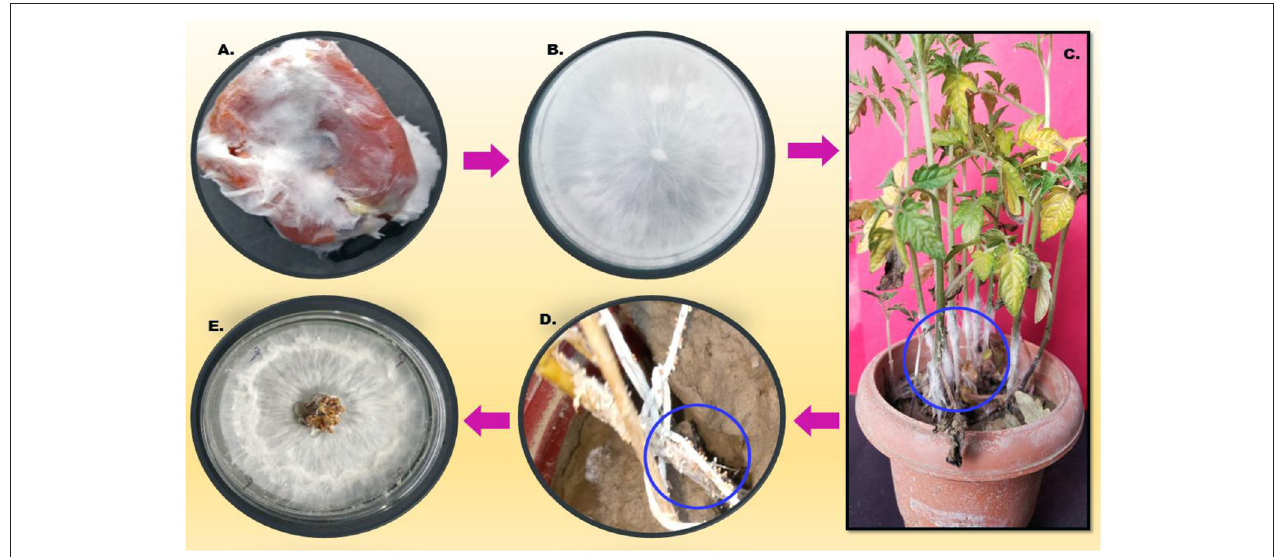
FIGURE 3 | Represents the effect of different BCAs against the virulent phytopathogenic fungus, S. rolfsii on 25-day old tomato plants that were planted under a glasshouse temperature and humidity condition. The results showed that BCAs, when used in consortia (B1P1), showed the lowest plant mortality, i.e., 15%, followed by singly inoculated and the highest plant mortality was observed in the positive control (PC), i.e., 84%.